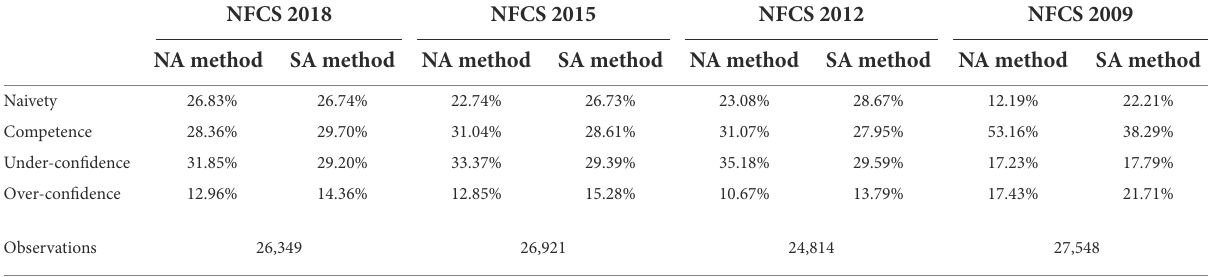
TABLE 4 Proportions of the four CFL groups measured with the two methods.